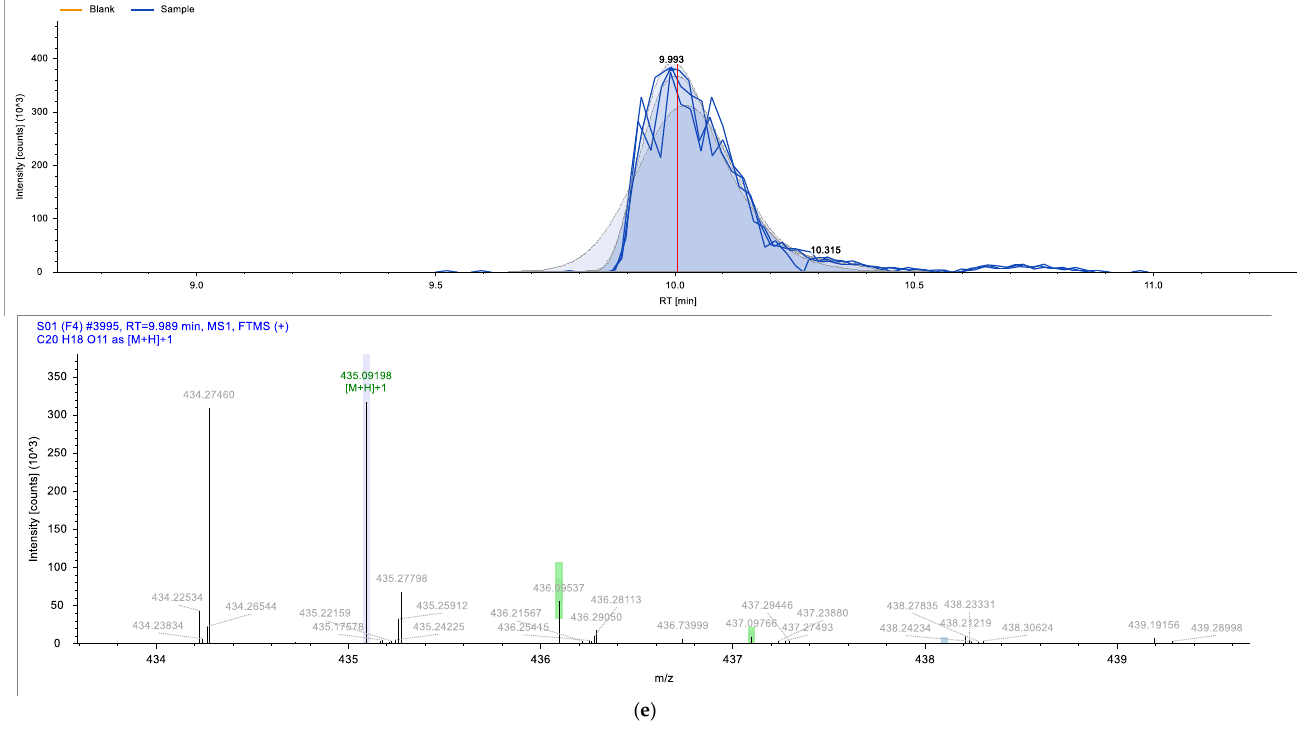
Figure 1. Shows the chromatogram of the five main chemical compounds in K. pinnata extract: ( a ) quercetin, ( b ) kaempferol, ( c ) apigenin, ( d ) epigallocatechin gallate, ( e ) avicularin.